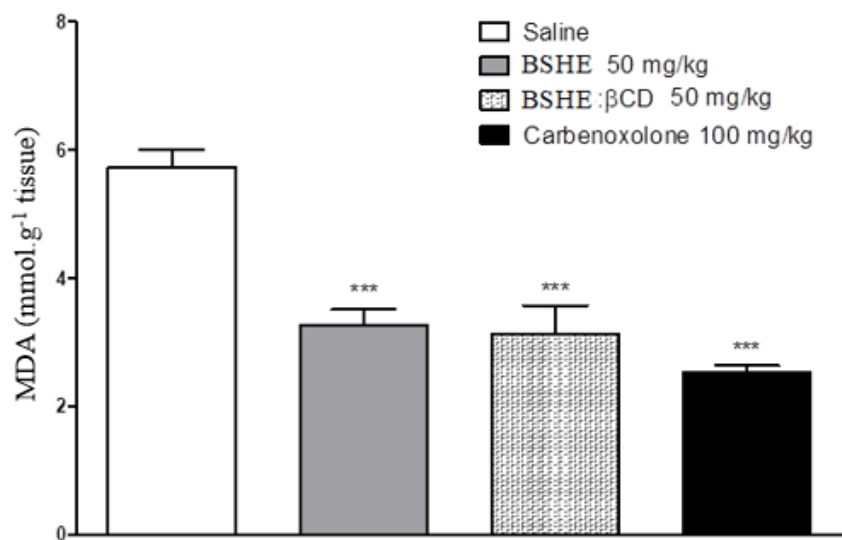
Figure 9. Detection of MDA in gastric tissue with gastric ulcer. BSHE, BSHE: β -CD inclusion com- plexes, and carbenoxolone (positive control) were used in concentrations of 50 mg/kg, 50 mg/kg, and 100 mg/kg, respectively. For negative control, saline was used. Data are expressed as mean ± E.P.M., *** p < 0.001, compared to control (ANOVA, followed by Tukey’s test).